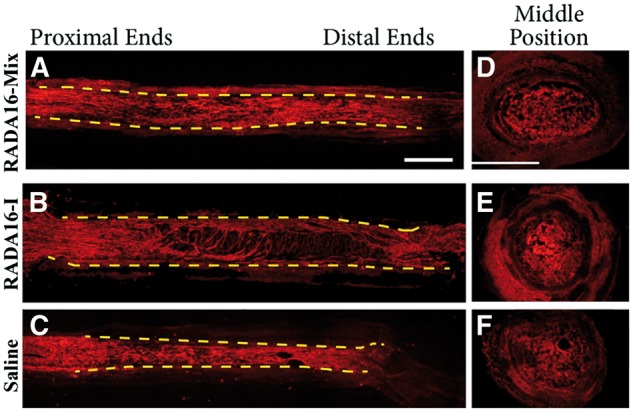
The longitudinal and transverse full views of axon regeneration 8 weeks after implanting different grafts (A) RADA16-mix, (B) RADA16-I group, (C) saline. The axons were labeled with rabbit anti-NF200 in red. The dash lines indicate the inside wall of the electrospun conduit. Scale bar: 1000 μm.